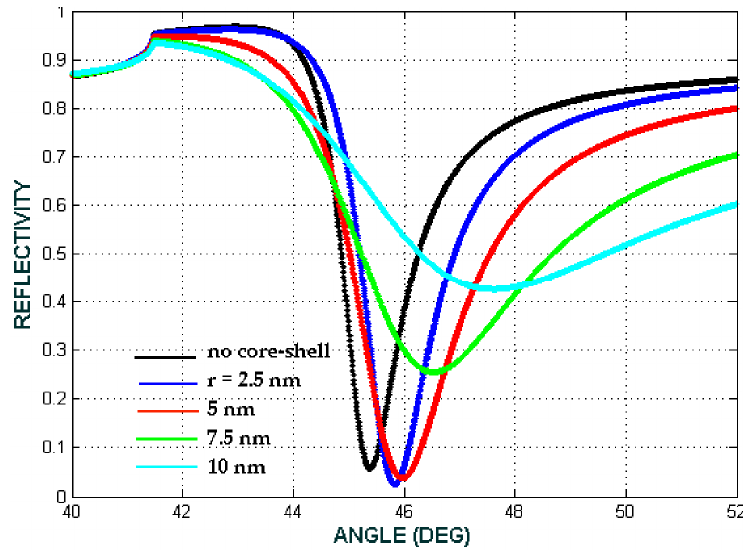
Figure 11. The ATR spectra for the volume fraction of the composite F = 0.1. The radii of the core-shell varied from 2.5 nm to 10 nm with a fixed ( b / a ) 3 = 0.73 (biomaterial sample is Hb cytoplasm with a refractive index of 1.3871 or the concentration 12.93 mmol L − 1 ).